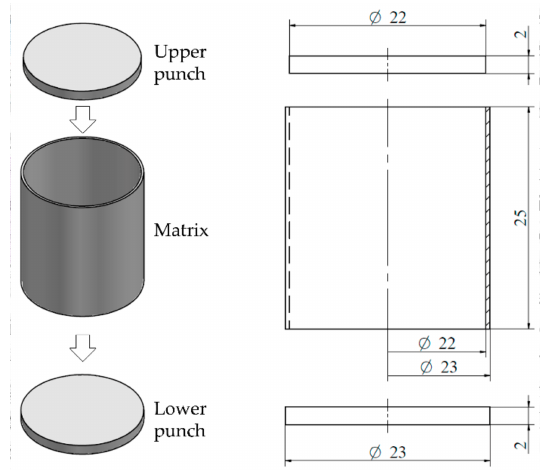
Figure 1. Geometries used in discrete element method (DEM) simulations. Dimensions are expressed in